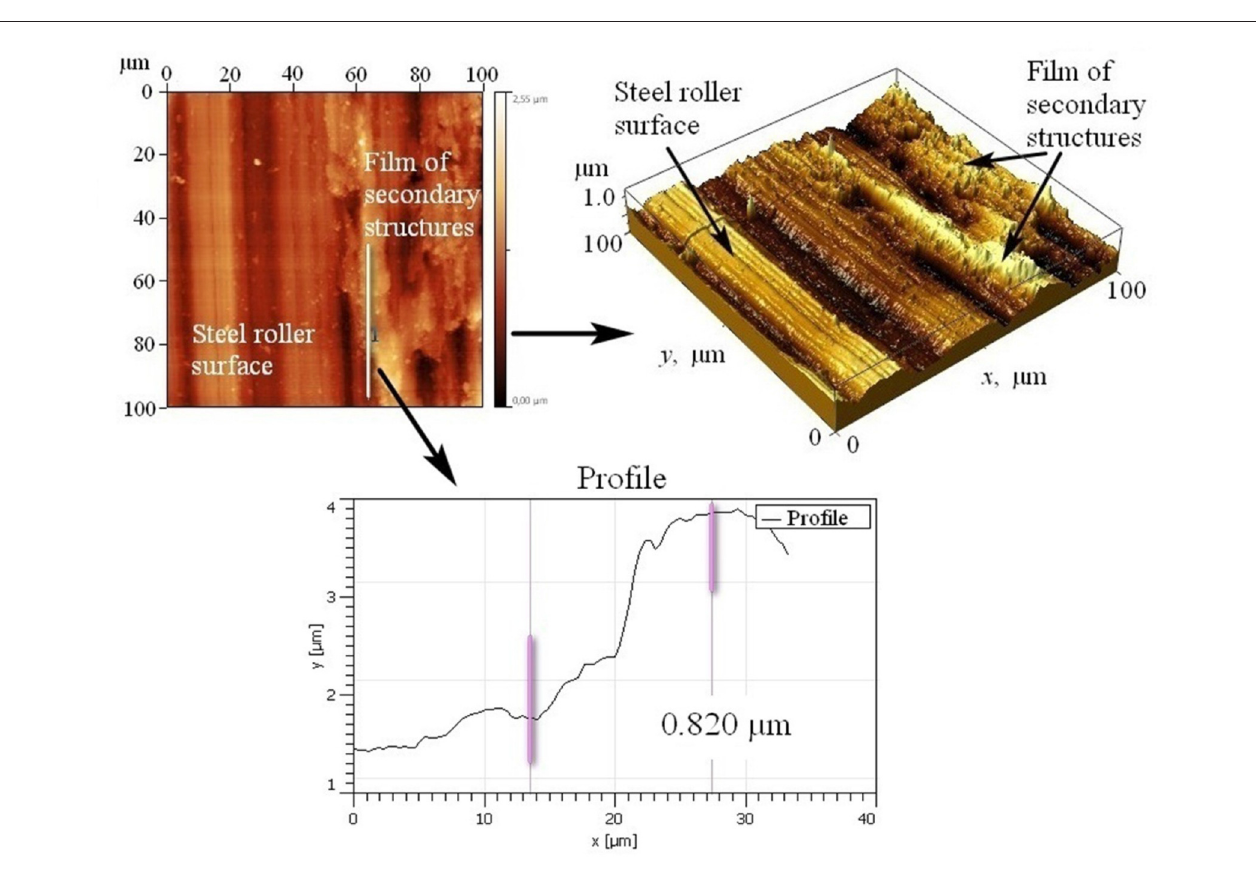
a high hardness. On the surface of the roller ( Figure 5B ), a film of secondary structures (SS) was found, the formation of which is due to the process of mass transfer of chemical elements from the surface of the shoe in the contact zone. The results of the SPM study of the roller after testing in the lubricant are presented in Figure 6